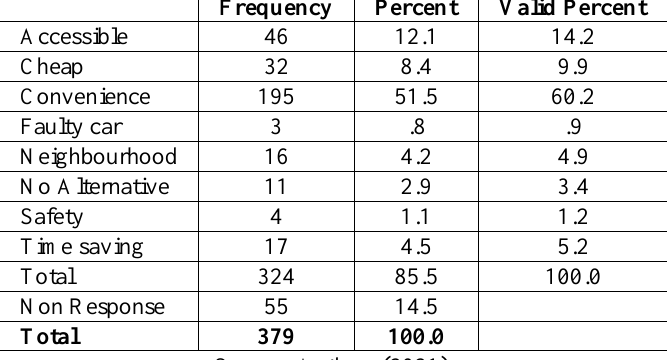
Table 5: Reason for Alternative chosen.